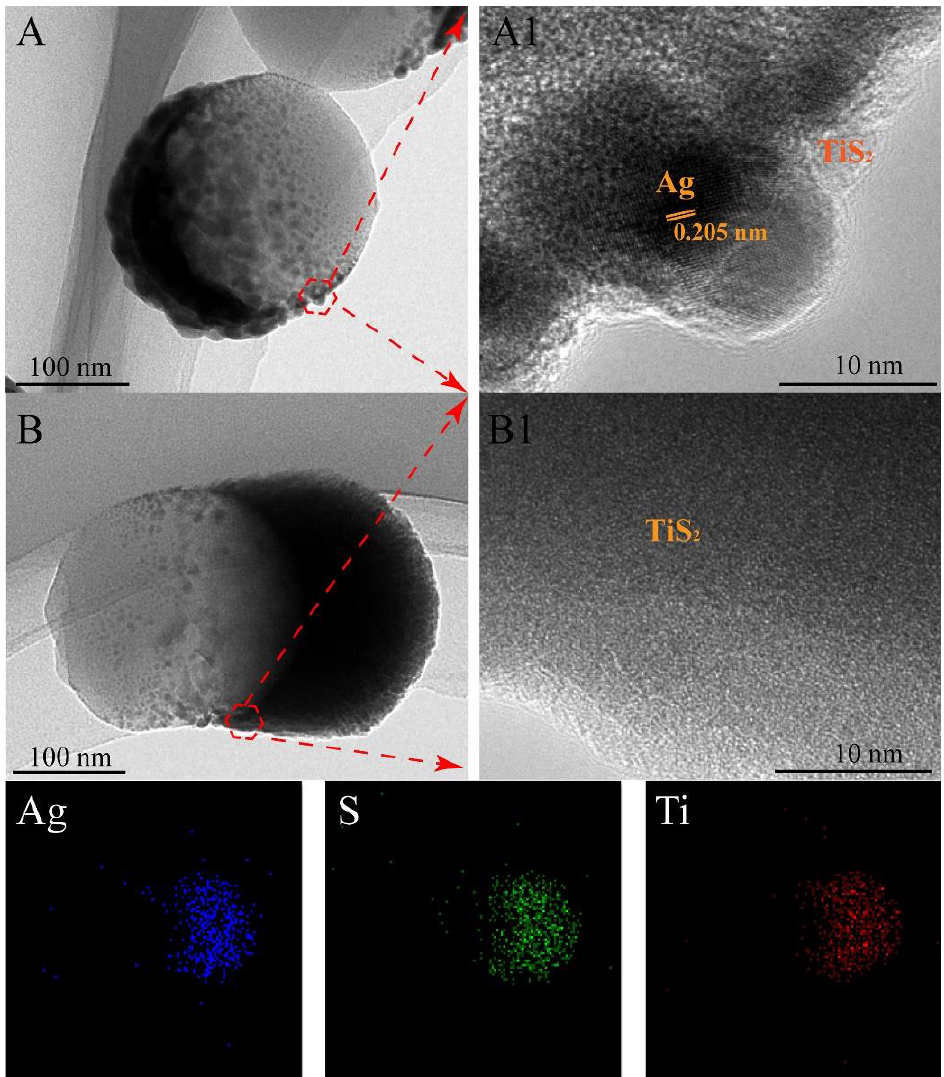
Figure 4. TEM and HRTEM images of ( A , A1 ) Ag 10 nm/TiS 2 (2 nm) nanostructures and ( B , B1 ) Ag 10 nm/TiS 2 (30 nm) nanostructures. The EDS elemental mapping is shown in Figure 4B. 10 nm / TiS 2 (30 nm) nanostructures. The EDS elemental mapping is shown in ( B